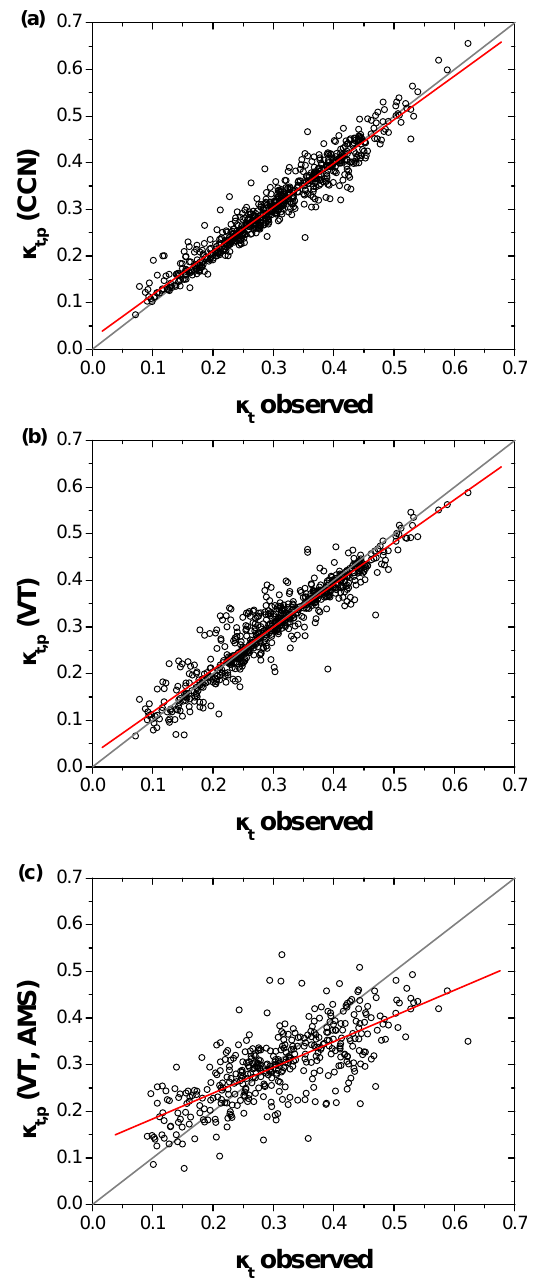
Fig. 9. Correlation plot of (a) the predicted κ t as calculated from the CCN data (MAF m ) and Eq. (3) ( κ t , p ( CCN ) ) versus the observed κ t , (b) the predicted κ t as calculated from the VTDMA data ( φ LV , 220 ) and Eq. (4) ( κ t , p ( VT ) ) versus the observed κ t , and (c) the predicted κ t as calculated from the VTDMA data ( φ LV , 220 ), AMS data ( f org , f inorg ), and Eq. (5) ( κ t , p ( VT , AMS ) ) versus the observed κ t . The grey lines are the 1:1 lines and the red lines are linear least squares fit lines through the data points with the following equation, corre- lation coefficient, and number of data points: (a) y = 0 . 02 + 0 . 94 x , R 2 = 0 . 94, n = 656; (b) y = 0 . 03 + 0 . 91 x , R 2 = 0 . 89, n = 656; and (c) y = 0 . 13 + 0 . 55 x , R 2 = 0 . 52, n =